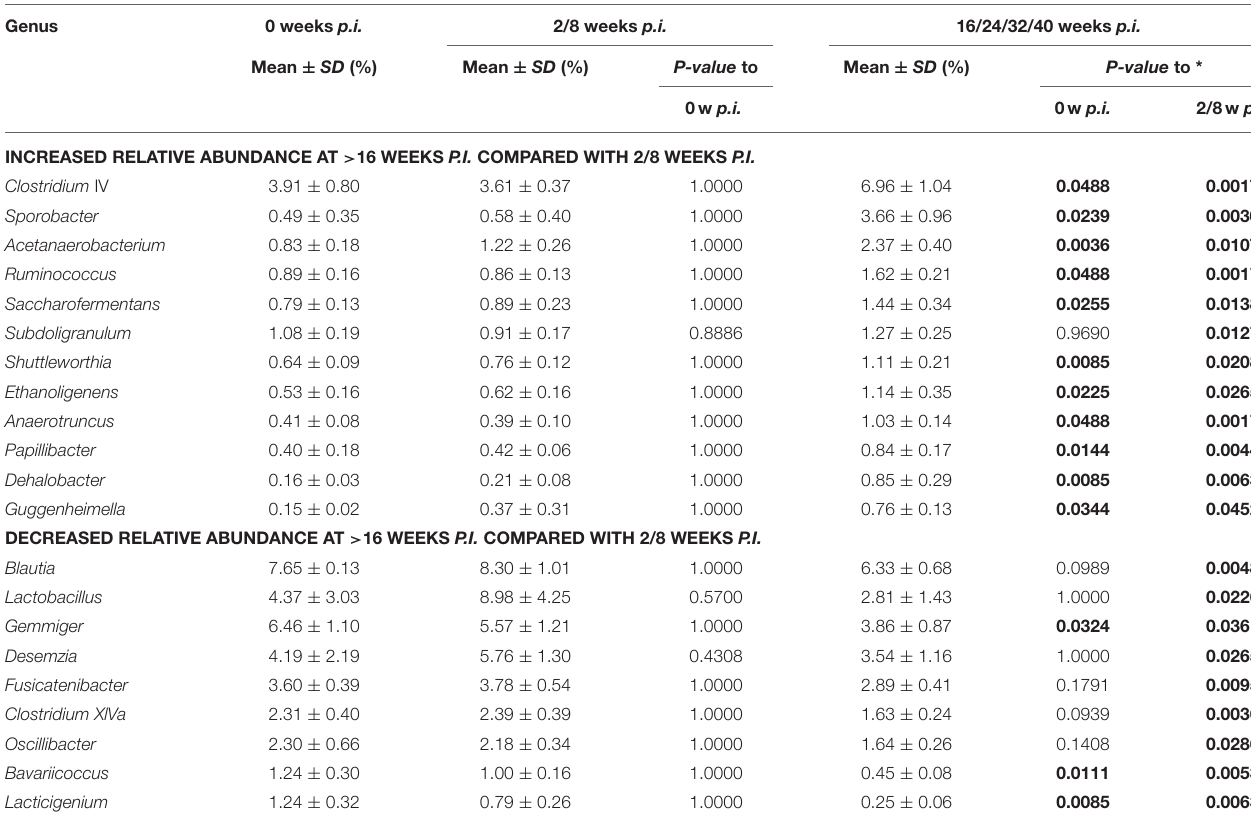
Bacterial genera exhibiting > 0.50% of relative abundance on average in total are listed. p.i., post-infection. * P-values were calculated using a non-parametric joint ranked Dunn test. Bold values represent P-values of <